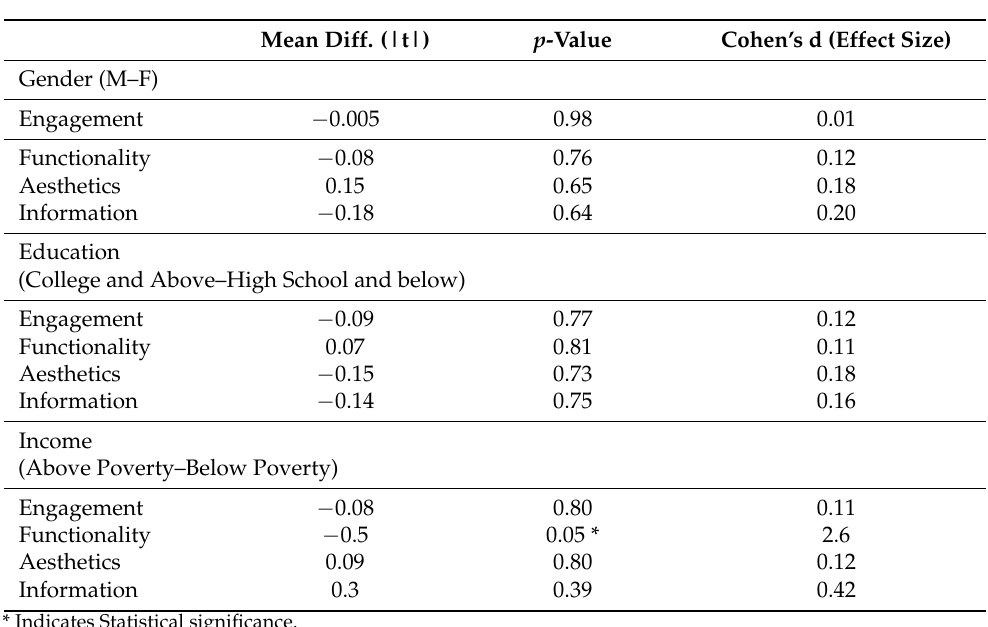
Table 2. Mean Difference ( p -Value) and Effect Size of Each Application Category Between Gender, Education, and